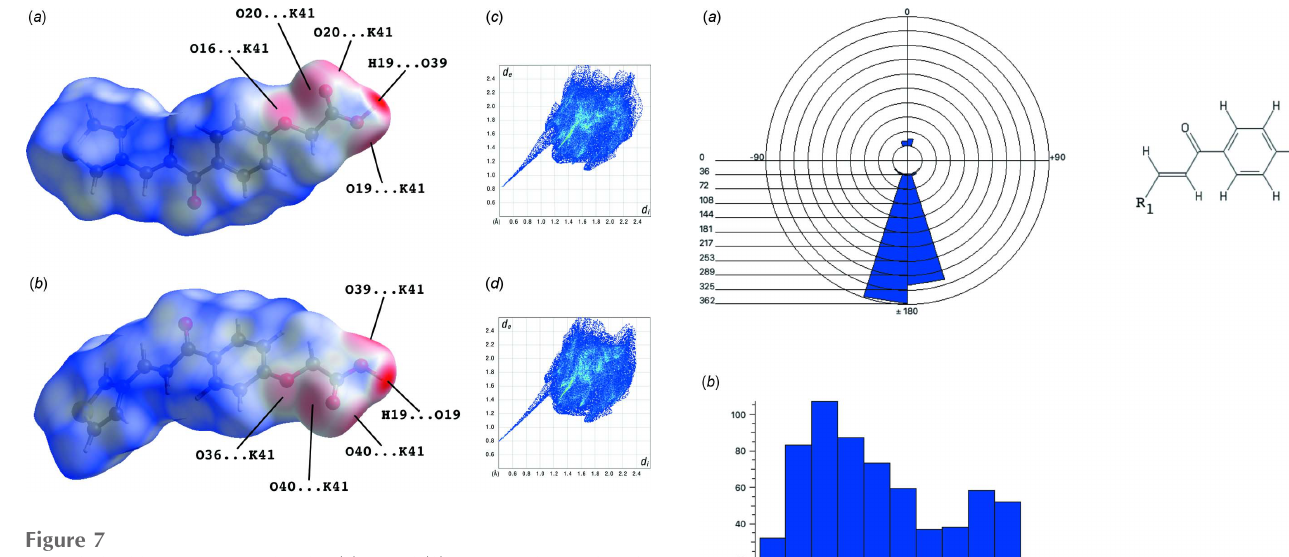
Figure 7 The Hirshfeld surfaces of molecules ( a ) A and ( b ) B mapped over d norm in the colour ranges (cid:4) 1.0475 to 1.0150 and (cid:4) 1.1101 to 1.0300 a.u., respectively, together with the full two-dimensional fingerprint plots for molecules ( c ) A and ( d ) B